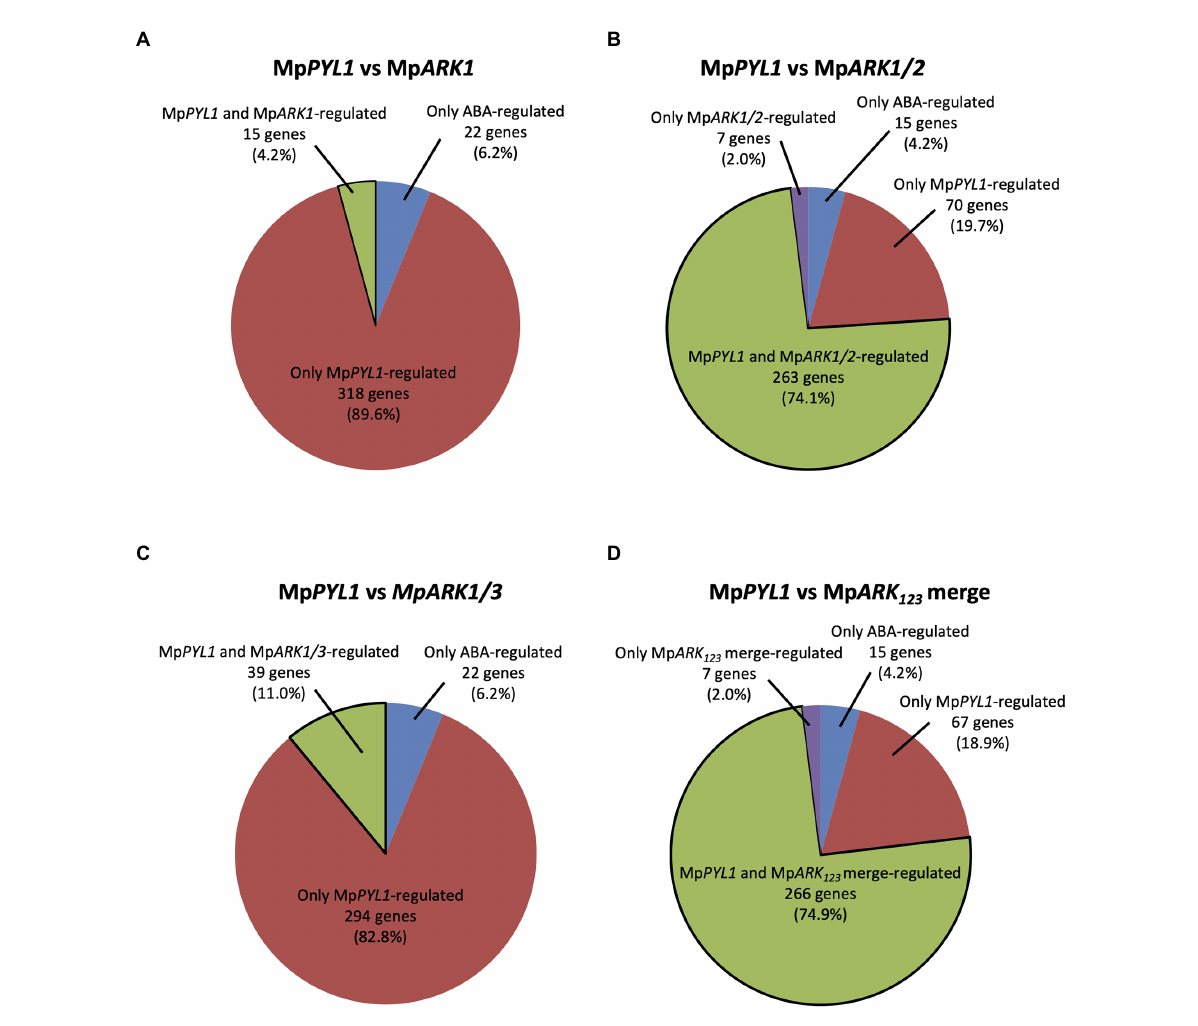
FIGURE 6 Relationships between ABA-induced genes mediated by the ABA receptor MpPYL1 and B3-Rafs. Using ABA-induced 355 genes commonly identified in this study and our previous study (Jahan et al., 2019), percentages of genes under the control of MpPYL1, B3-Rafs and both are analyzed. Genes for which expression in Mp pyl1 ge , Mp ark1 ge , Mp ark1/2 ge , and Mp ark1/3 ge is less than half of WT are represented as Mp PYL1 -, Mp ARK1 -, Mp ARK1/2 -, and Mp ARK1/3 -regulated genes (A–C) . The result of analysis against the merge of Mp ark1 ge , Mp ark1/2 ge , and Mp ark1/3 ge (Mp ARK 123 merge) is also shown (D)